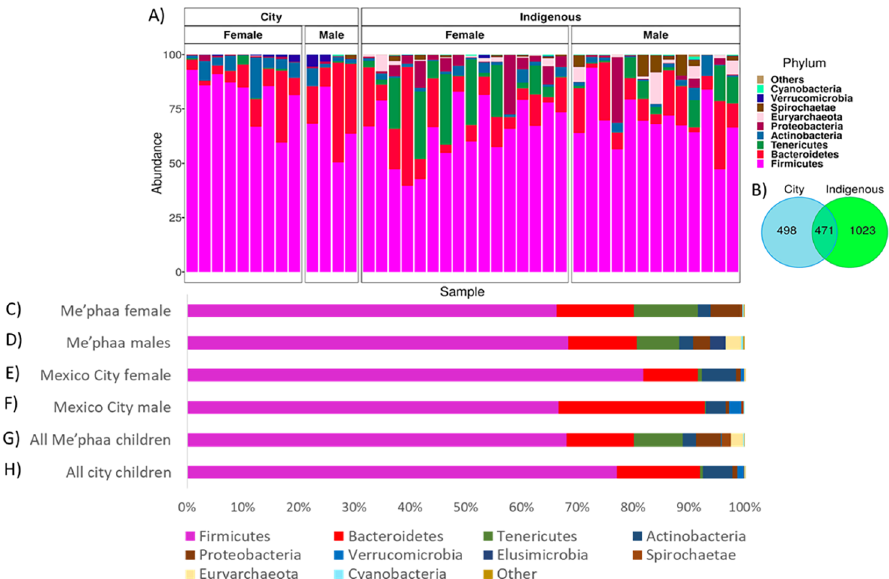
Figure 2. Relative abundance of microbiota. ( A ) Distribution of bacterial composition (16S rRNA Figure 1. This is a figure, Schemes follow the same formatting. If there are multiple panels, they should V4) at phylum level of male and female children from M é xico City and the Me’phaa community, be listed as: ( a ) Description of what is contained in the first panel. ( b ) Description of what is contained phyla with relative abundances < 1% were included in the “others” category; ( B ) Venn diagram of in the second panel. Figures should be placed in the main text near to the first time they are cited. A ASVs from M é xico City and the Me’phaa community; ( C ) Relative abundance of gut microbiota (GM) caption on a single line should be centered. female children from Me’phaa community; ( D ) Relative abundance of GM male children from the Me’phaa community; ( E ) Relative abundance of GM female children from M é xico City; ( F ) Relative abundance of GM male children from the M é xico City community; ( G ) Relative abundance of GM from all children in the Me’ phaa community; ( H ) Relative abundance of GM from all children in the M é xico City